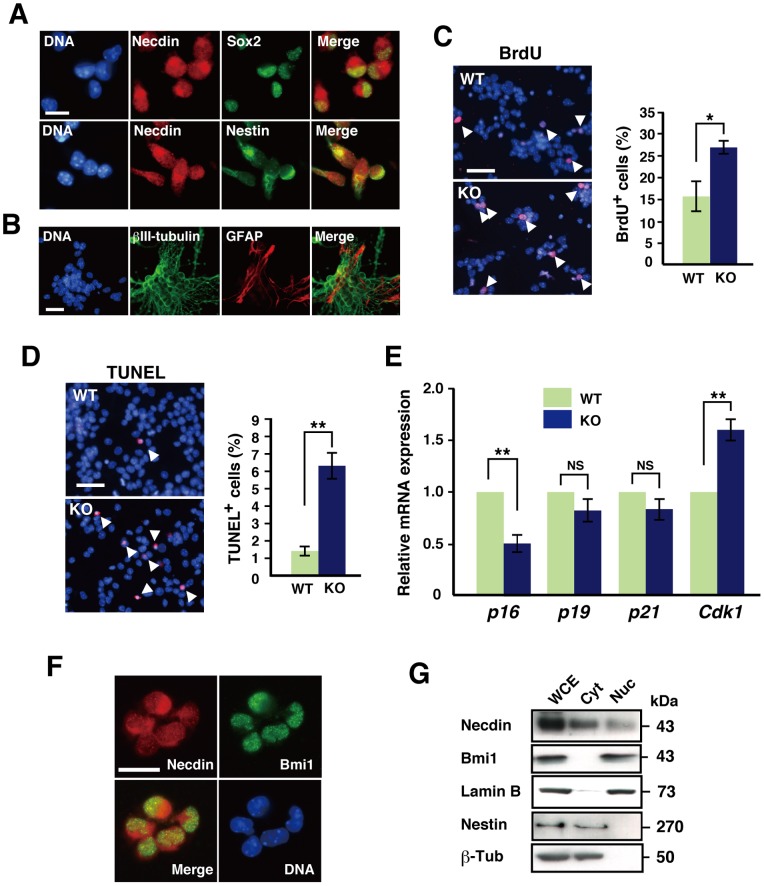
Necdin deficiency decreases p16 expression and increases Cdk1 expression in primary NPCs.(A) Expression of necdin, Sox2, and nestin in primary NPCs. Primary NPCs were prepared from the neocortex at E14.5 and subjected to double-immunostaining for necdin and Sox2 or nestin. (B) Double-staining for βIII-tubulin (green) and GFAP (red) in differentiated cells. Primary NPCs were induced to differentiate by growth factor withdrawal. (C, D) BrdU incorporation and TUNEL analyses. Primary NPCs were immunostained for BrdU (C) or labeled by TUNEL (D), and BrdU+ or TUNEL+ cells (red) were counted (total 100 cells examined). Arrows point to representative positive cells. Chromosomal DNA (DNA) was stained with Hoechst 33342 (blue) (A−D). (E) Expression of cell cycle-regulatory genes. p16, p19, p21, and Cdk1 mRNAs expressed in NPCs were analyzed by qRT-PCR. (F) Coexpression of necdin and Bmi1 in NPCs. Primary NPCs were double-stained for necdin and Bmi1. (G) Subcellular distribution of necdin and Bmi1. The nucleus and cytoplasm of NPCs were fractionated, and the protein levels were analyzed by Western blotting. Abbreviations: WCE, whole cell extract; Cyt, cytoplasm; Nuc, nucleus. Lamin B was used as a nuclear marker, and nestin and β-tubulin (β-Tub) as cytoplasmic markers. Values in (C−E) represent the mean ± SEM (n = 3), *p<0.05, **p<0.01, NS, not significant. Scale bars; 20 µm in (A, B, F), 50 µm in (C, D).